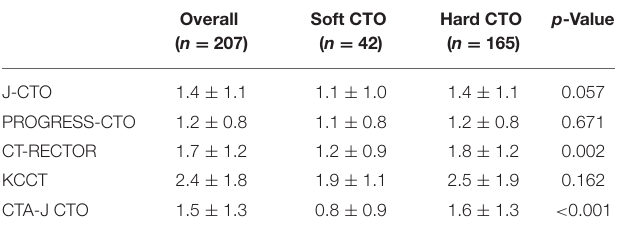
TABLE 4 | Predictive assessment of different scoring